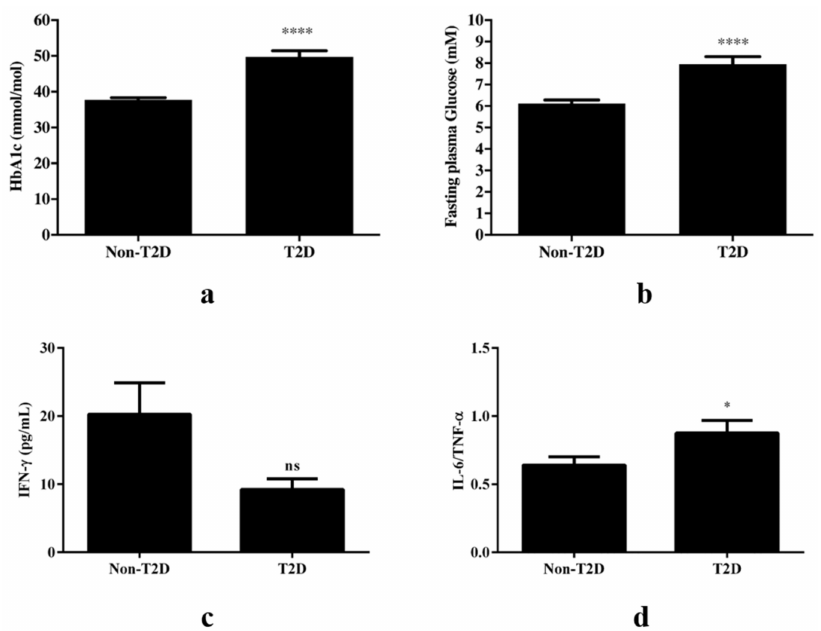
Figure 2. T2D is associated with an increase in IL-6/TNF- α ratio. ( a ) HbA1c ( n = 63 for non-T2D, n = 36 for T2D) and ( b ) fasting plasma glucose ( n = 62 for non-T2D, n = 35 for T2D) levels were higher in T2D patients, p < 0.0001 for both. ( c ) A clear trend towards reduced IFN- γ levels was observed in patients with T2D when compared to the non-T2D group ( p = 0.06) and ( d ) Fasting plasma IL-6/TNF- α ratio ( n = 49 for non-T2D, n = 33 for T2D) was significantly increased in T2D compared with the non-T2D group ( p < 0.05). Comparisons between groups were done with an unpaired t -test. ns = no significant; * p < 0.05; **** p <